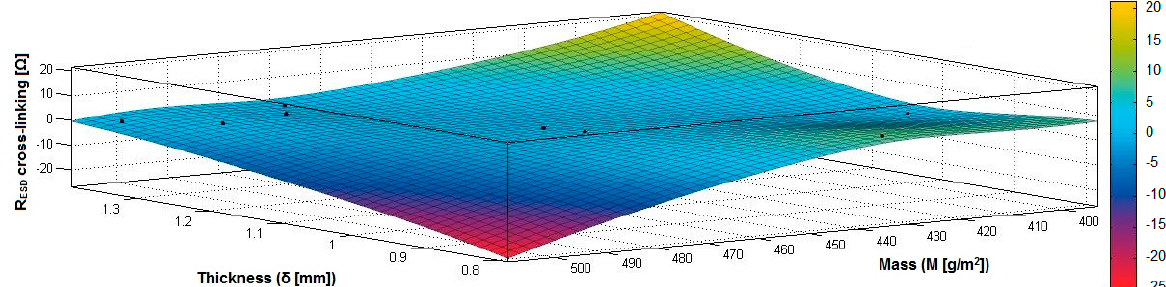
Figure 26. 3D representation R ESD after crosslinking = f(M, δ ) samples preliminarily treated in RF plasma O 2 using RF 1 generator and power 200 W.